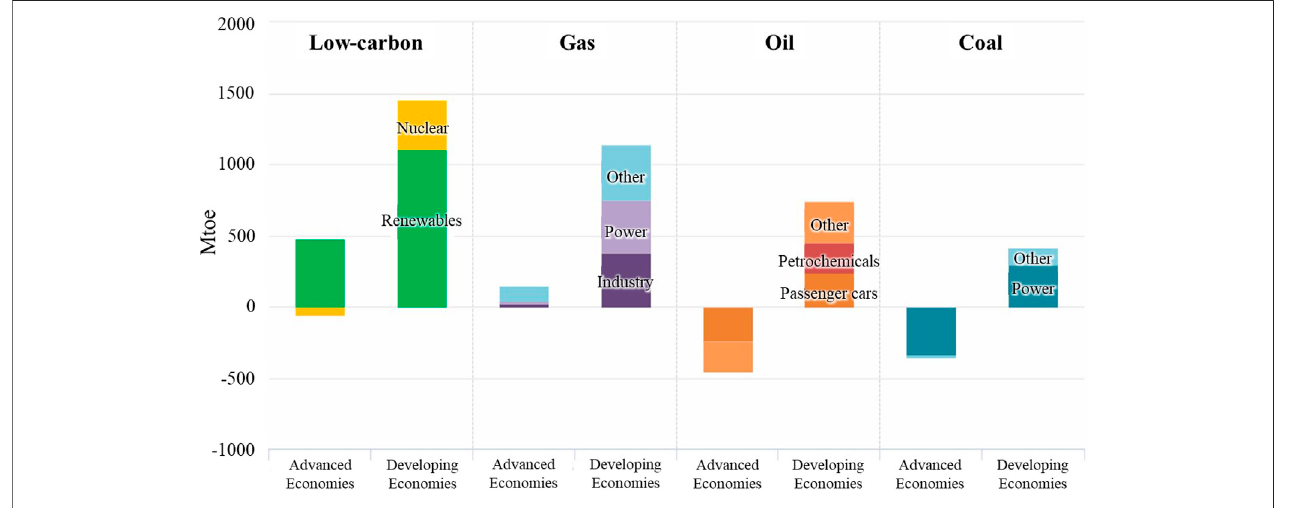
FIGURE 5 | Change in total primary energy demand, 2017 – 40 in the new policies scenario (NPS) (IEA